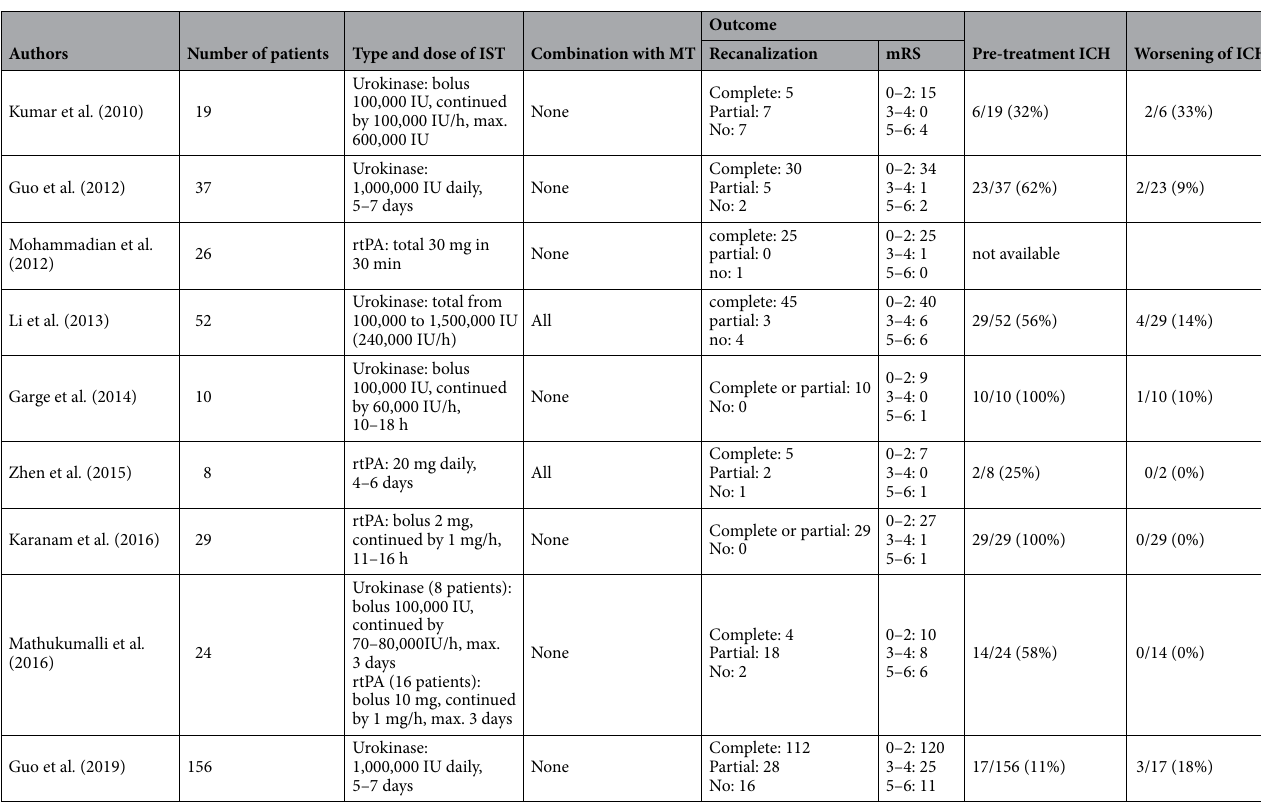
Table 4. Studies using intrasinus thrombolysis in the treatment of cerebral venous sinus thrombosis. ICH intracerebral hemorrhage, IST intrasinus thrombolysis, mRS modified Rankin Scale, MT mechanical thrombectomy, rtPA recombinant tissue plasminogen